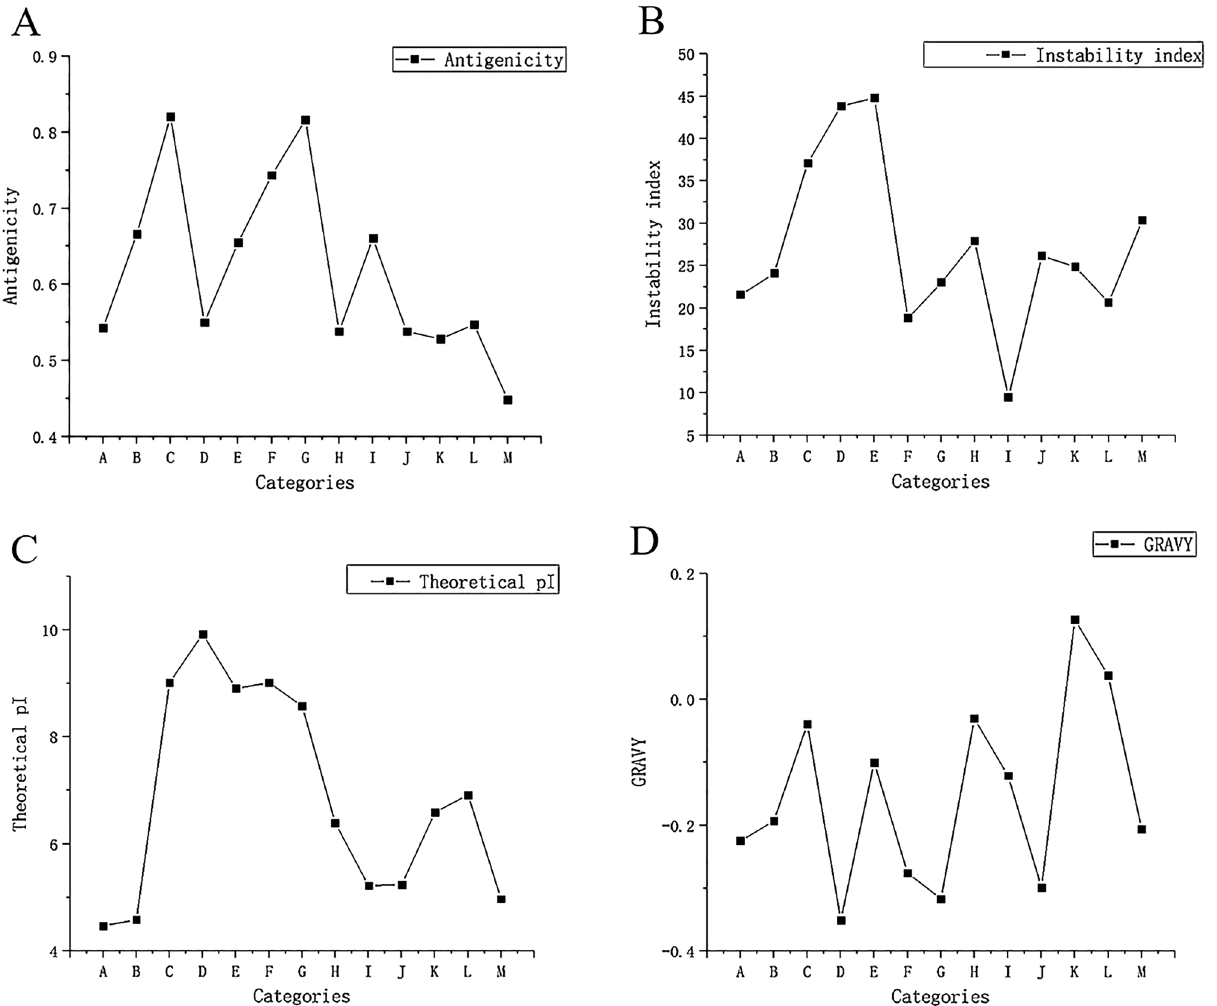
Figure 1. ( A ) Antigenicity prediction of 13 proteins. ( B) Instability index prediction of 13 proteins. ( C ) Theoretical pi prediction of 13 proteins. ( D ) GRAVY prediction of 13 proteins. As illustrated in the figure, “A” stands for Omp2a, “B” stands for Omp2b, “C” stands for Omp10, “D” stands for Omp16, “E” stands for Omp19, “F” stands for Omp22, “G” stands for Omp25, “H” stands for Omp28, “I” stands for Omp31, “J” stands for BtpB, “K” stands for BLS, “L” stands for BCSP31, and “M” stands for P39.